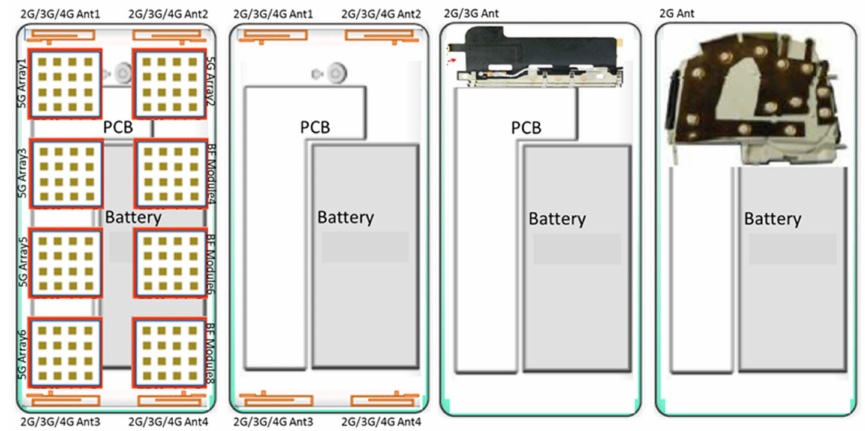
Figure 1. The antenna layout evolution on